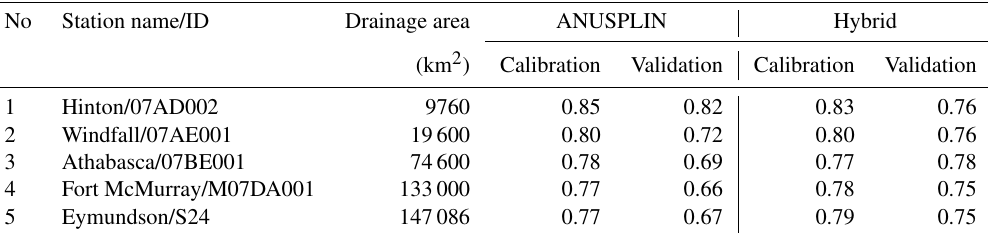
Table 8. Comparison of NSE values for hydrologic simulations forced by ANUSPLIN and the hybrid climate datasets at the main stream of the ARB.